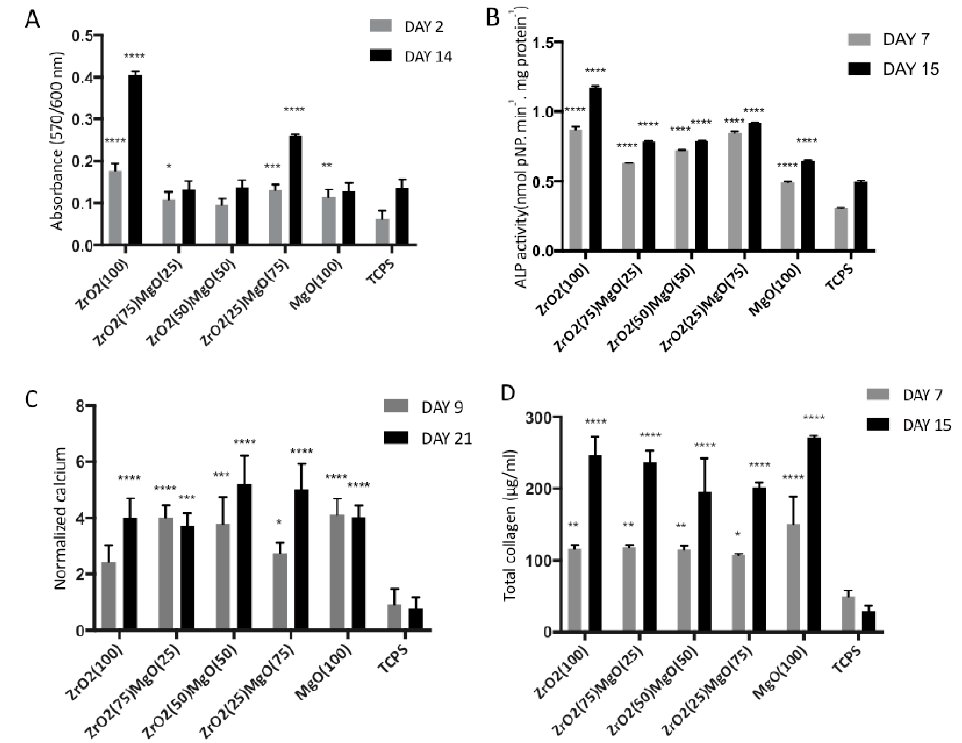
Figure 7. ( A ) Cell viability and proliferation on zirconia and magnesia ceramics after 2 and 14 days of culture, ( B ) alkaline phosphatase activity on the different ceramic substrates on days 7 and 15 in culture, ( C ) normalised calcium biomineralisation of MC3T3-E1 cells cultured for 7 and 14 days on the five ceramic materials after staining with alizarin red and ( D ) levels of total collagen produced by pre-osteoblastic cells cultured on the five ceramic substrates for 7 and 15 days. Data are expressed as mean of triplicate samples ± standard deviation (SD). Asterisks indicate statistical significance compared to the TCPS control surface at each experimental time point (*: p < 0.05, **: p < 0.01, ***: p < 0.001, ****: p < 0.0001).